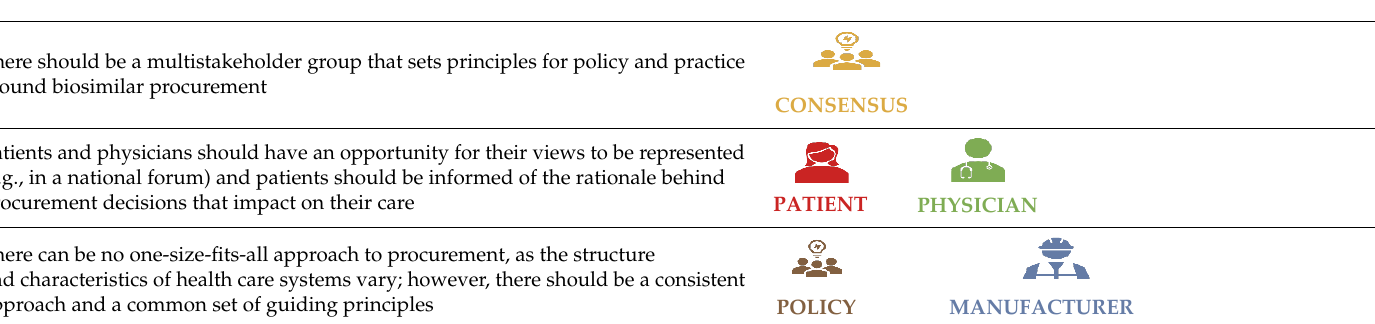
Table 2. Consensus on drivers and risks to biosimilar market sustainability (competition and